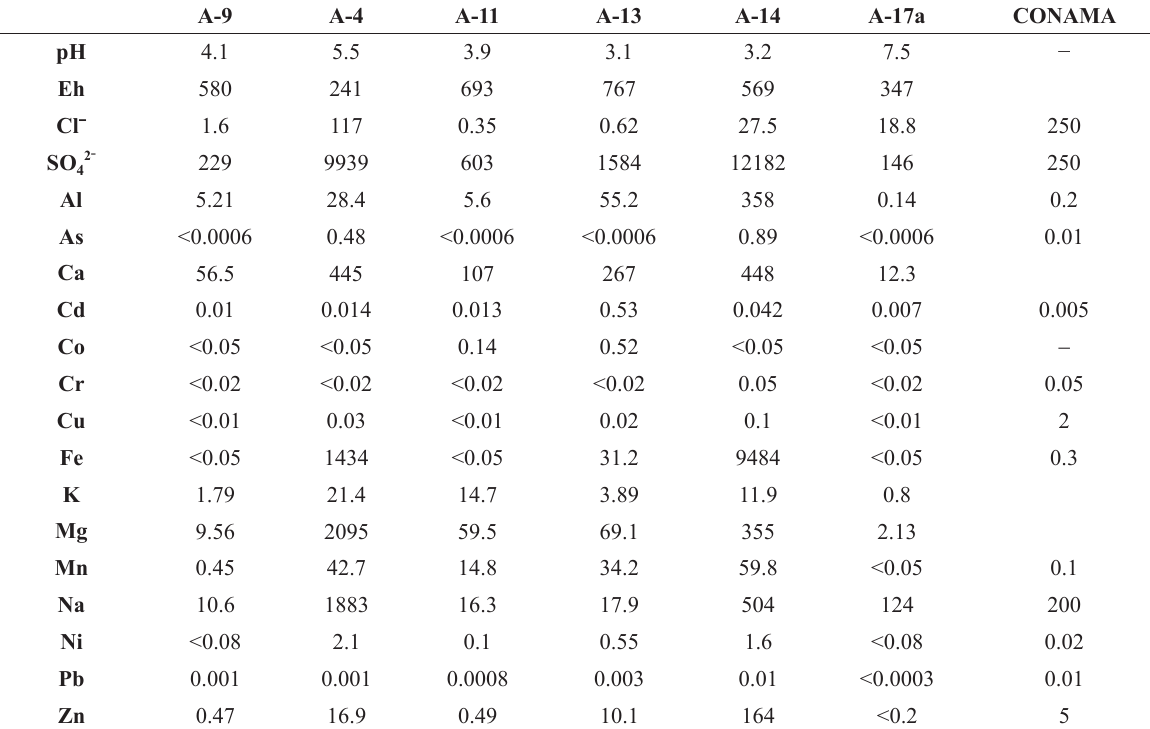
Values of pH, Eh (mV) and chemical concentrations (in mg L −1 ) of groundwater samples from piezometric wells. Values shown with the “less than” symbol (“<”) are detection limits, and CONAMA (Environmental National Council) values (in mg L −1 ) are maximum permissible limits established by the Brazilian legislation in groundwater used for human consumption (BRAZIL